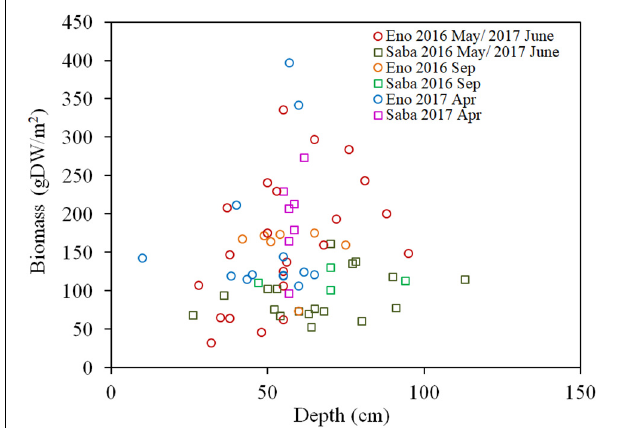
FIGURE 8 | Biomass of E . densa as a function of water depth. The sample collected month is represented by the month indicated in the legend. Eno and Saba represent Eno and Saba rivers, including tributaries,